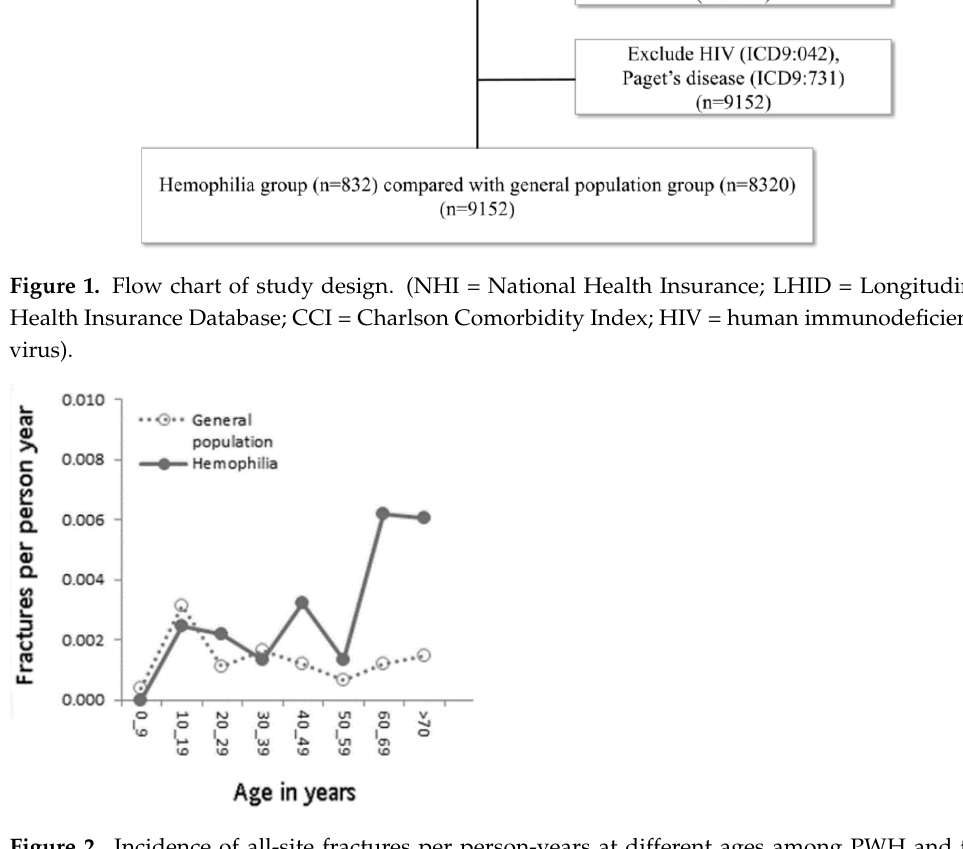
Figure 2. Incidence of all-site fractures per person-years at different ages among PWH and the matched control